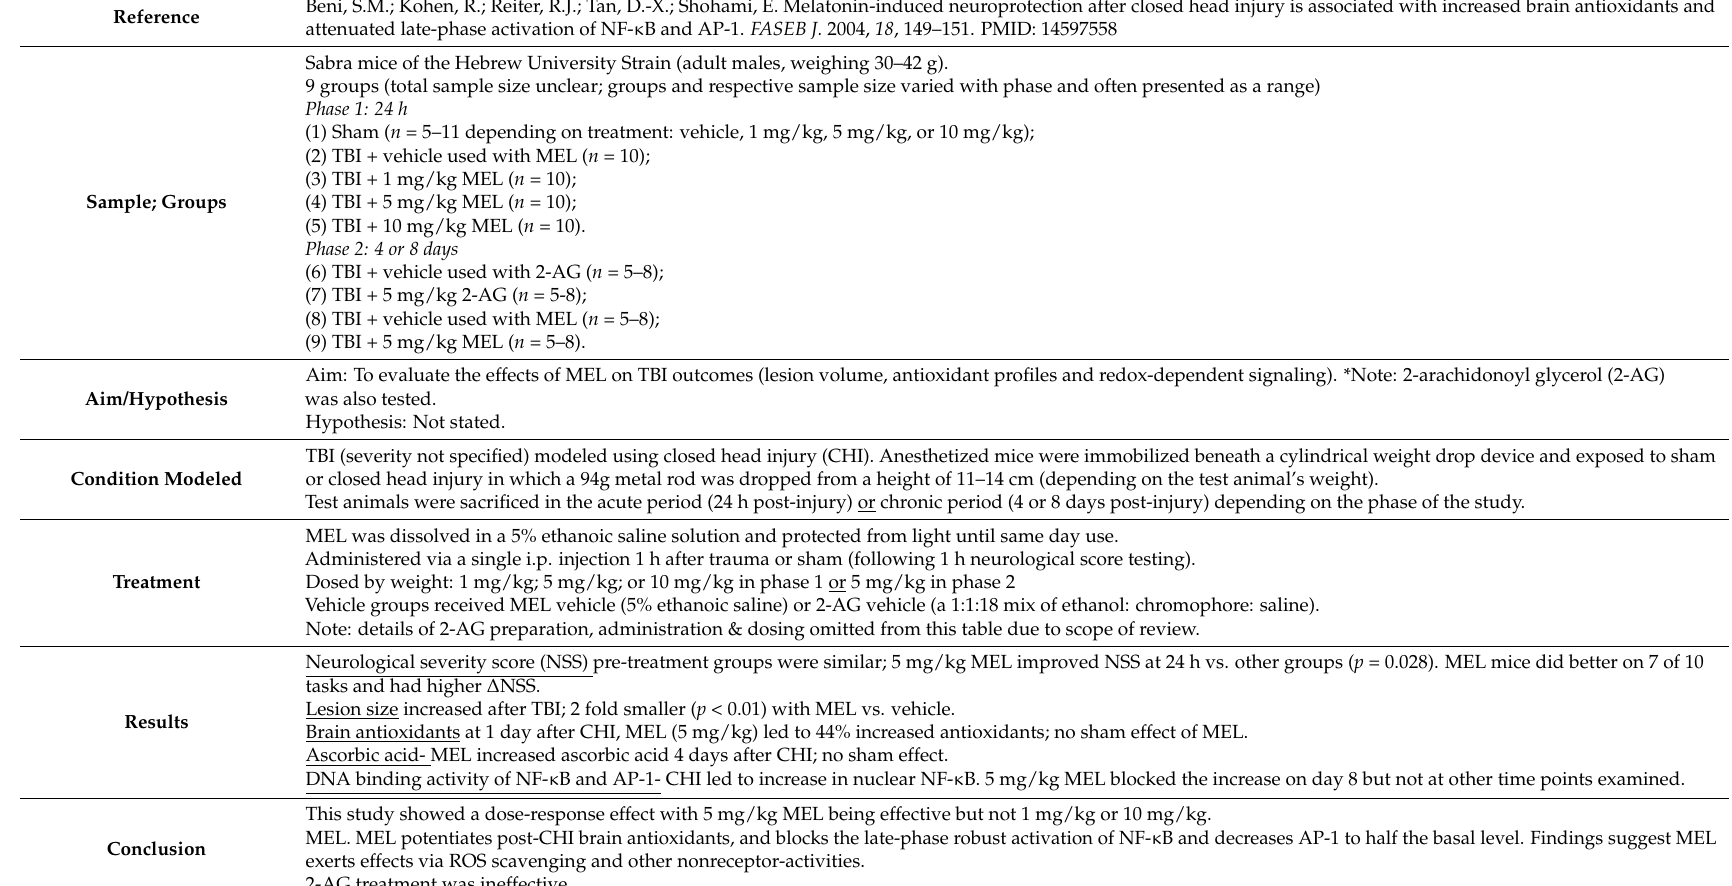
Table A4. Beni et al. (2004) Study